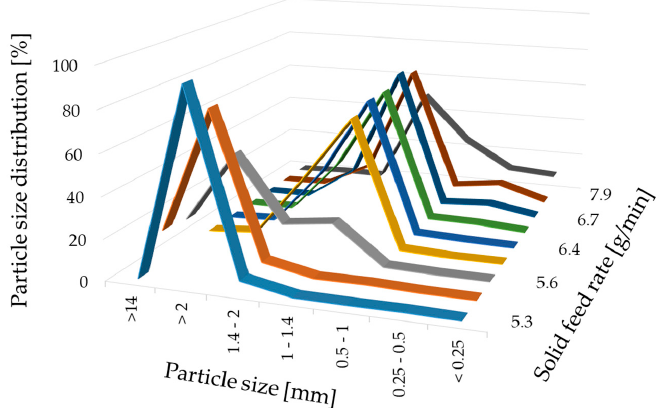
Figure 3. Particle size distribution (%) after sieve analysis of NAM-MCC pellets (80%:20%) after extrusion and spheronisation (3 min, 15 g) with different solid feed rates (g/min). The granulating liquid was distilled water with a constant feed of 1.74 g/min.